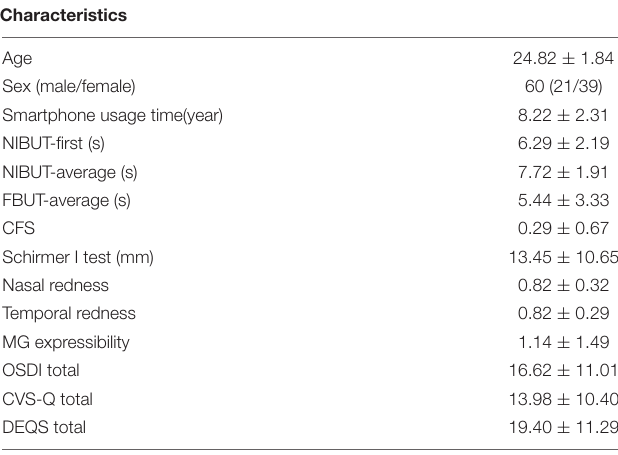
TABLE 1 | Baseline characteristics of